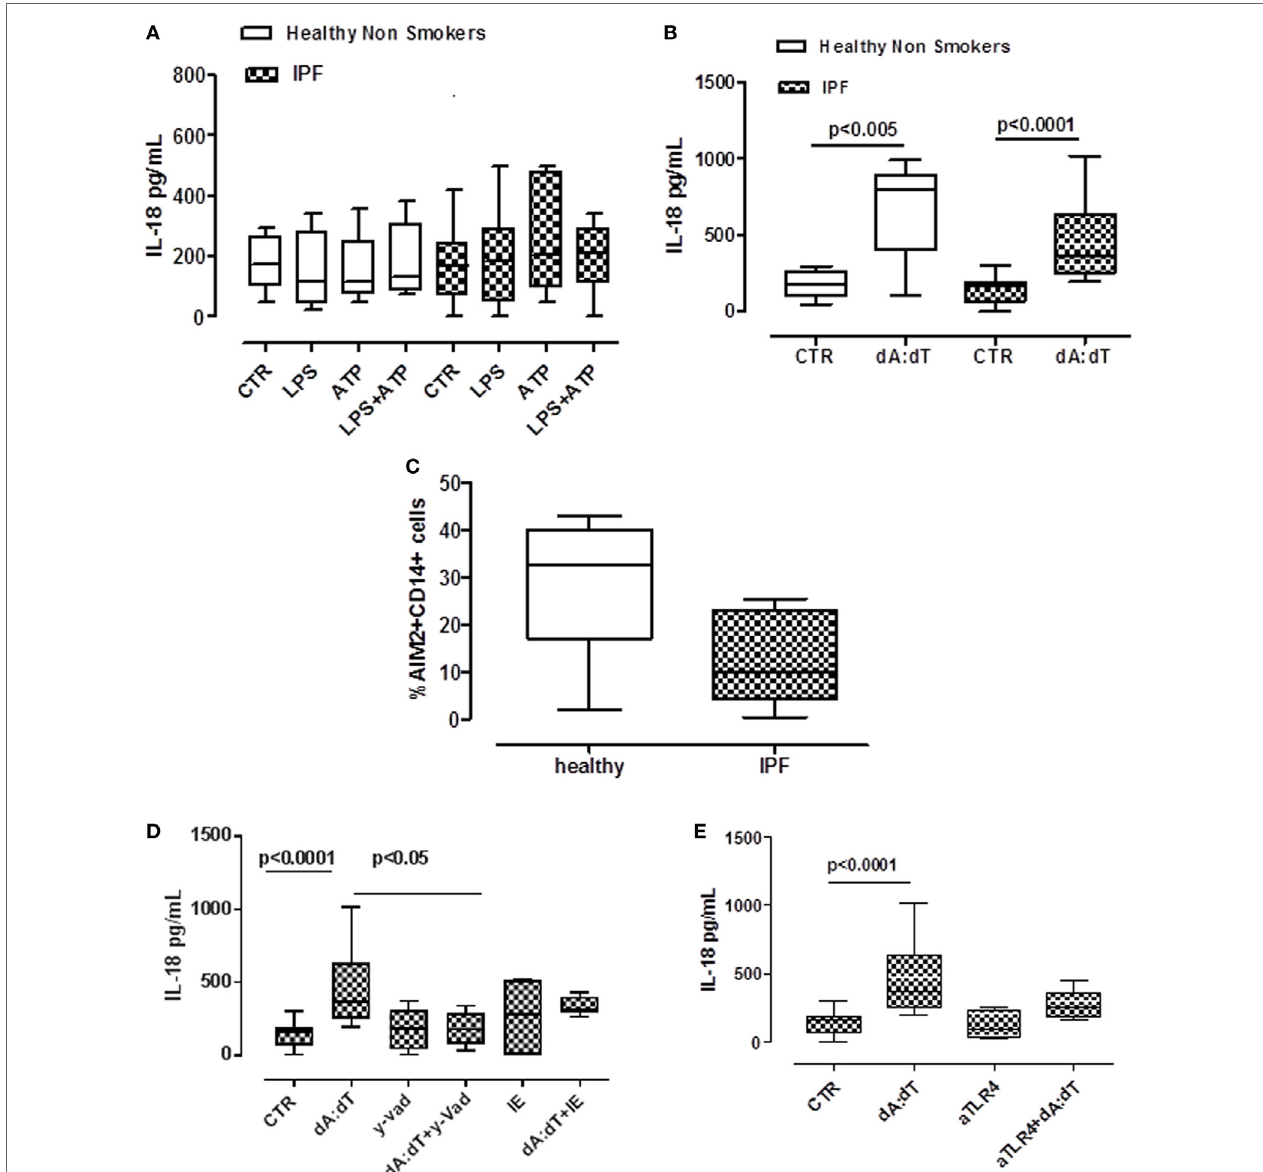
FigUre 4 | IL-18 release from idiopathic pulmonary fibrosis (IPF)-derived peripheral blood mononuclear cells (PBMCs) is absent in melanoma 2 (AIM2)/caspase-1 dependent. (a) LPS ± ATP treatment (5 h) of PBMCs did not induce a significant increase of IL-18 levels both in IPF patients and healthy subjects. (B) Poly dA:dT (dA:dT, 1 µg/ml) stimulation (5 h) of PBMCs isolated from IPF patients and healthy subjects significantly increased IL-18 release compared with respective control. (c) Expression of AIM2 in CD14 + cells. (D) Caspase-1 inhibition reduced IL-18 release after dA:dT addition, unlike caspase-8 inhibition. Similarly, TLR4 blockade did not alter IL-18 release after dA:dT administration (e) . Data are represented as median ± interquartile range ( n = 13). Statistically significant differences were determined by one-way ANOVA followed by Bonferroni’s multiple comparison